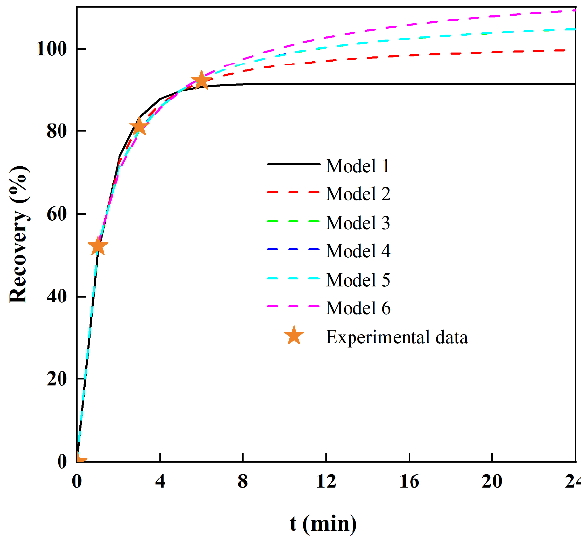
Figure 4. Comparison of different kinetic models fitted to the experimental data of Test No. 1. The fitting curves obtained from models 3, 4, and 5 overlapped completely.